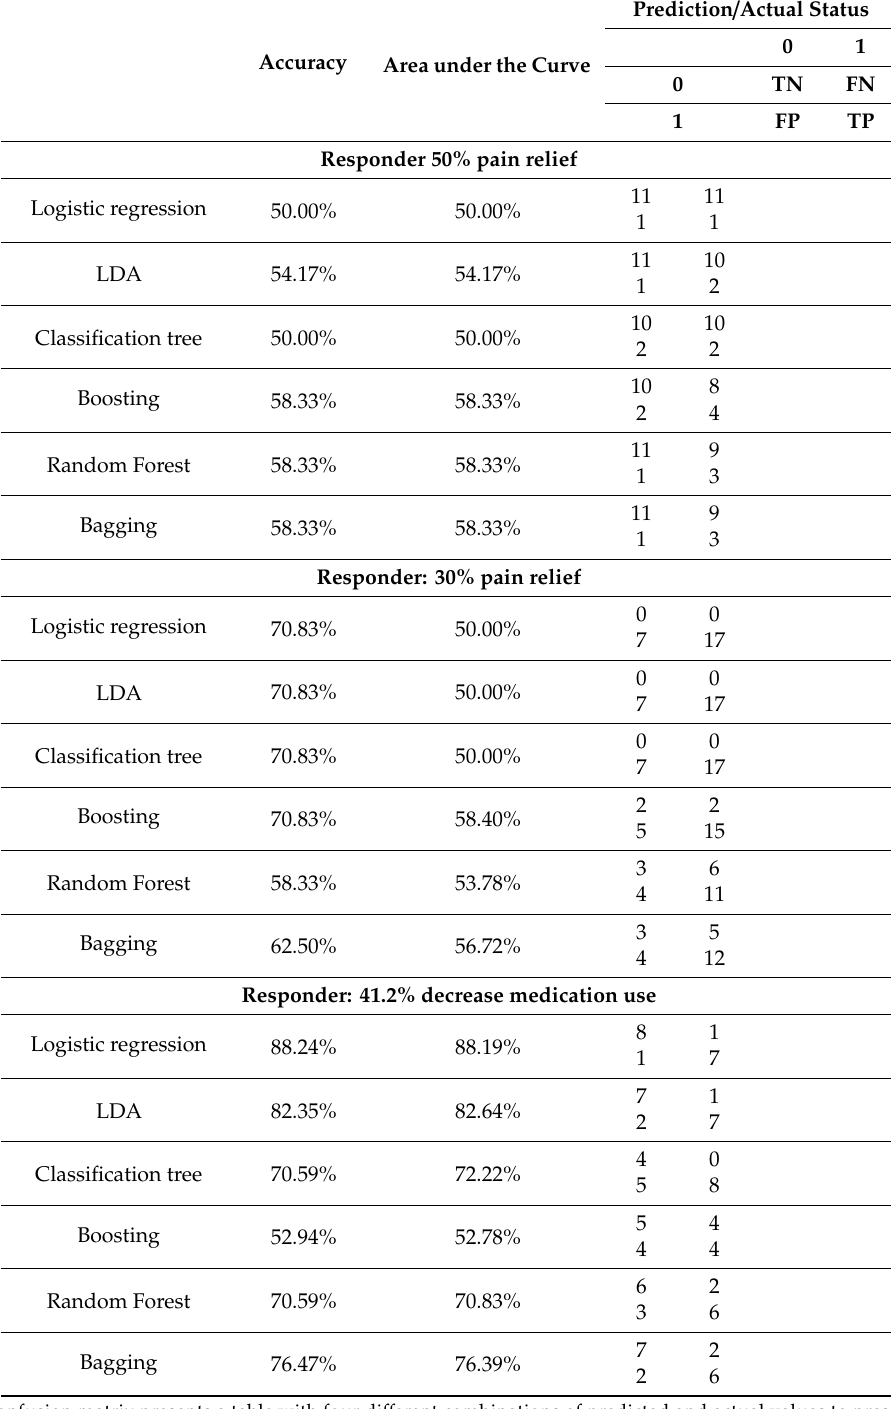
Table 2. Comparison between machine learning techniques applied on the validation